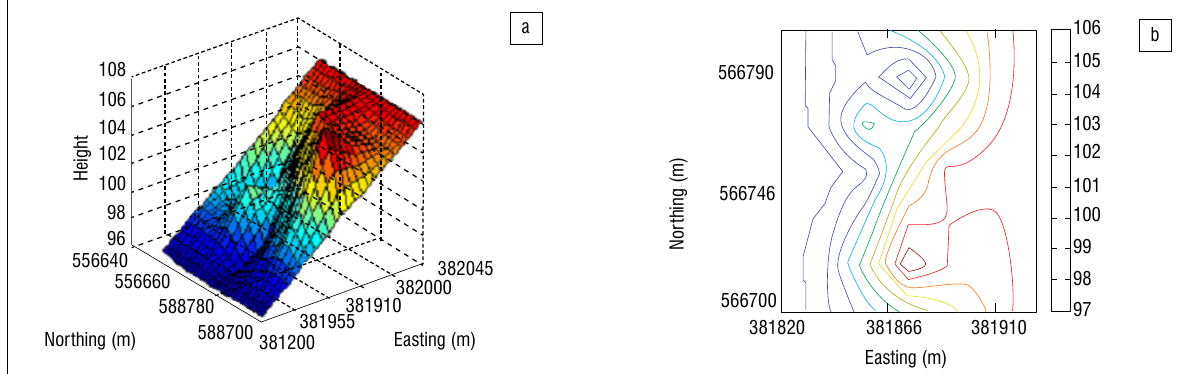
Figure 8: Artificial neural network method (a) digital terrain model plot and (b) contour